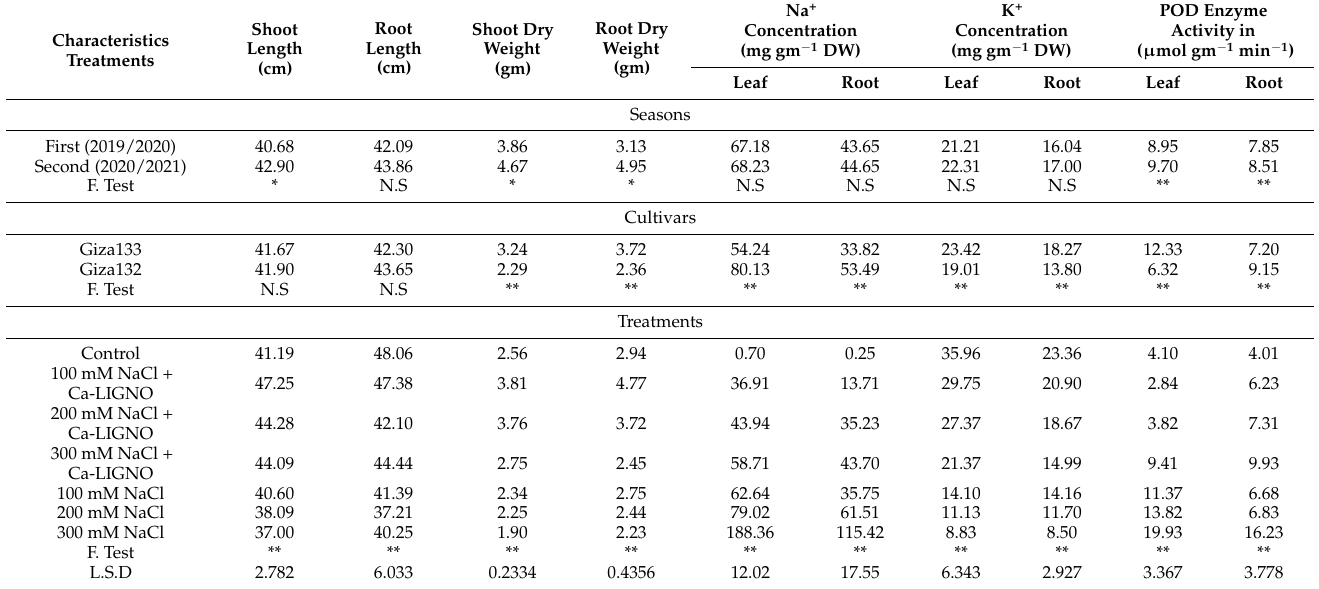
Table 2. Means of shoot and root lengths, shoot and root dry weights, Na + and K + concentrations, and peroxide enzyme activity in both leaf and root tissues of Giza133 and Giza132 barley cultivars under different treatments (control, NaCl concentrations, and NaCl concentrations + Ca-LIGNO) during two seasons 2019/2020 and 2020/2021.